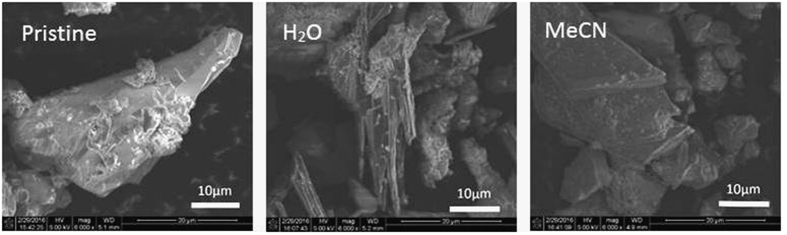
SEM images of pristine Sn3S7(trenH)2 and MB stained Sn3S7(trenH)2 functionalized in water and acetonitrile.